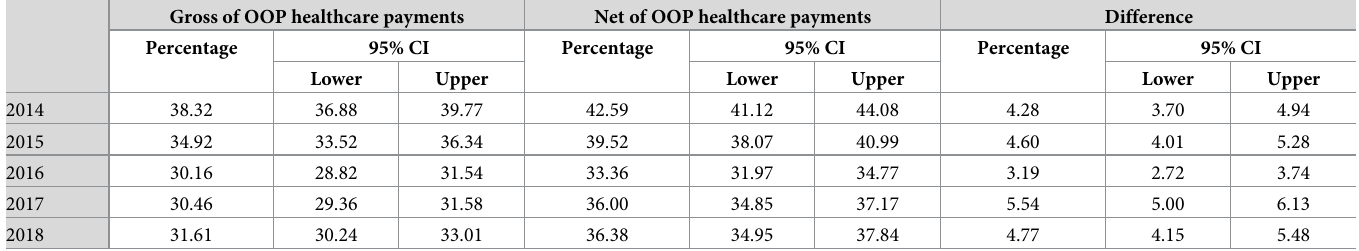
Table 5. Trends in the poverty headcount and poverty gap before and after OOP payments for health in Armenia between 2014 and 2018 using the US$5.50 per per- son per day poverty line. Gross of OOP healthcare payments